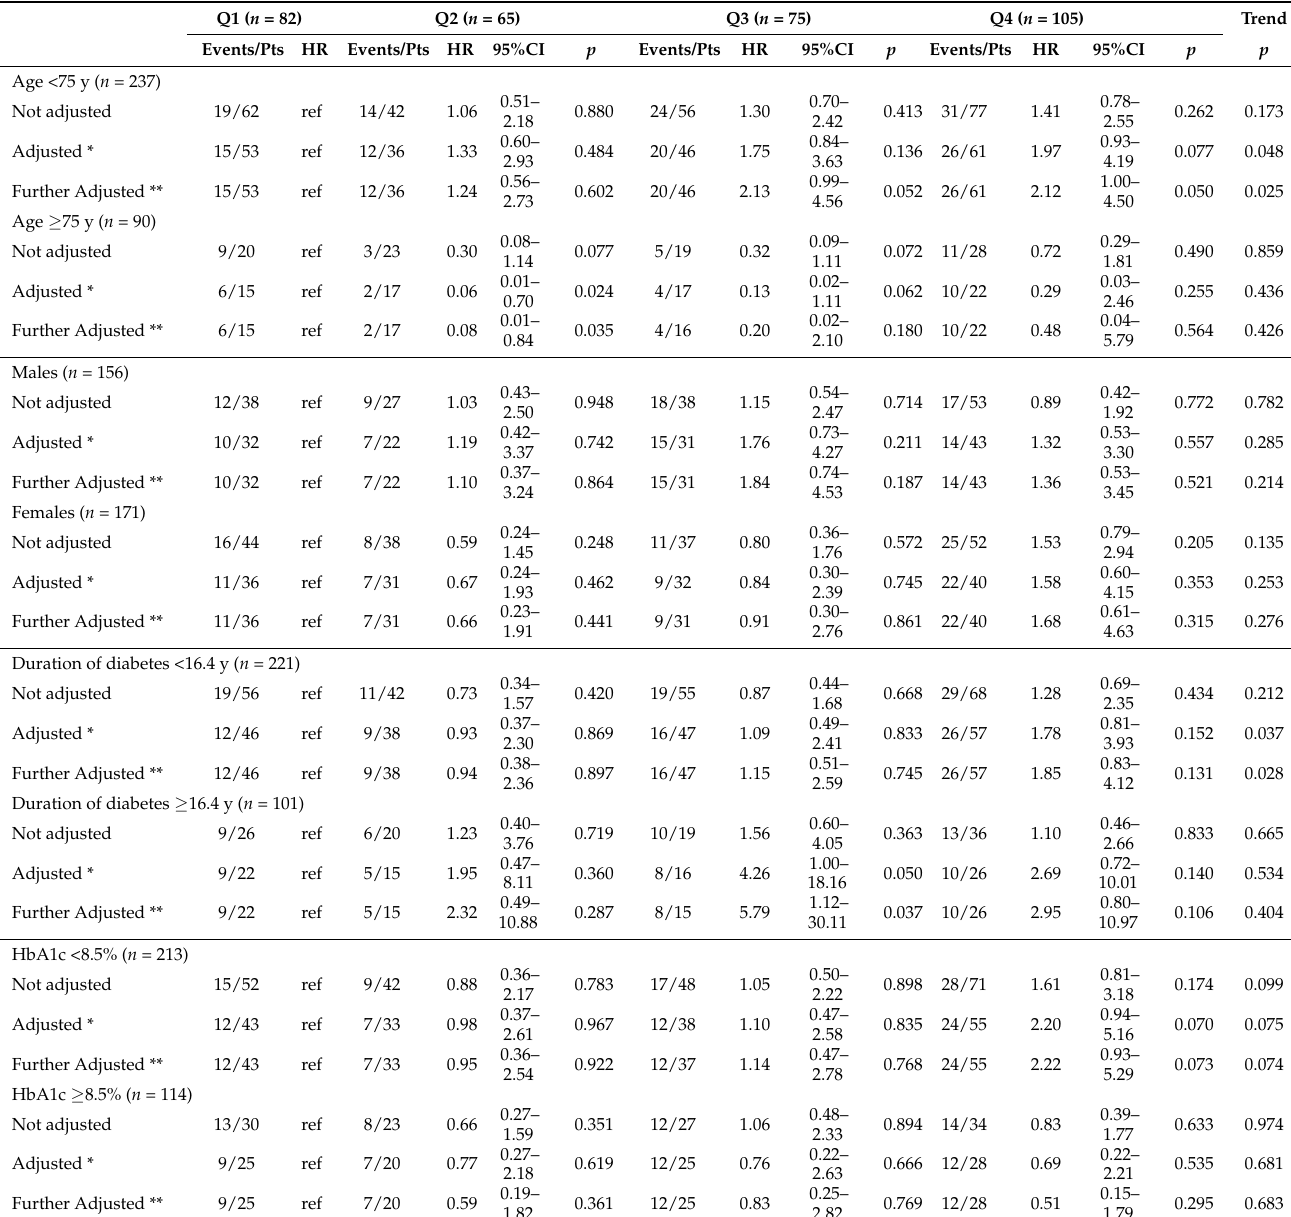
Table 4. Subgroup analysis of quartile of sodium and incidence of diabetic